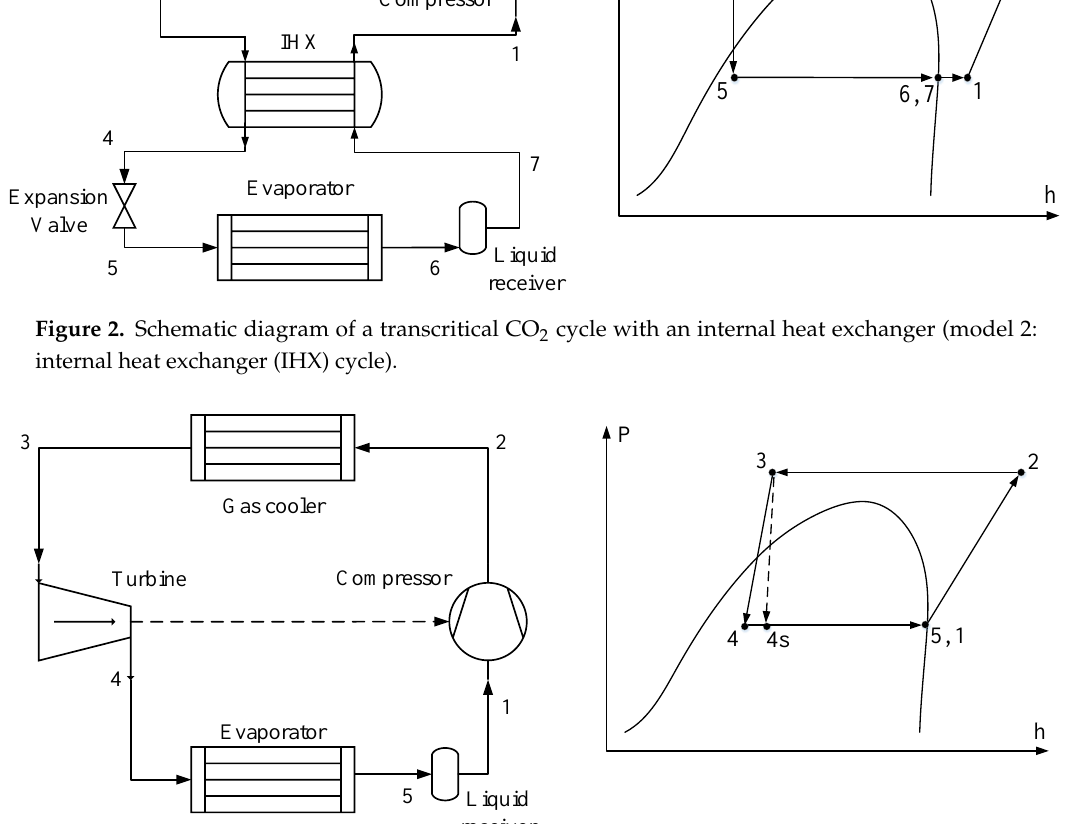
Figure 2. Schematic diagram of a transcritical CO 2 cycle with an internal heat exchanger (model 2: internal heat exchanger (IHX) cycle).